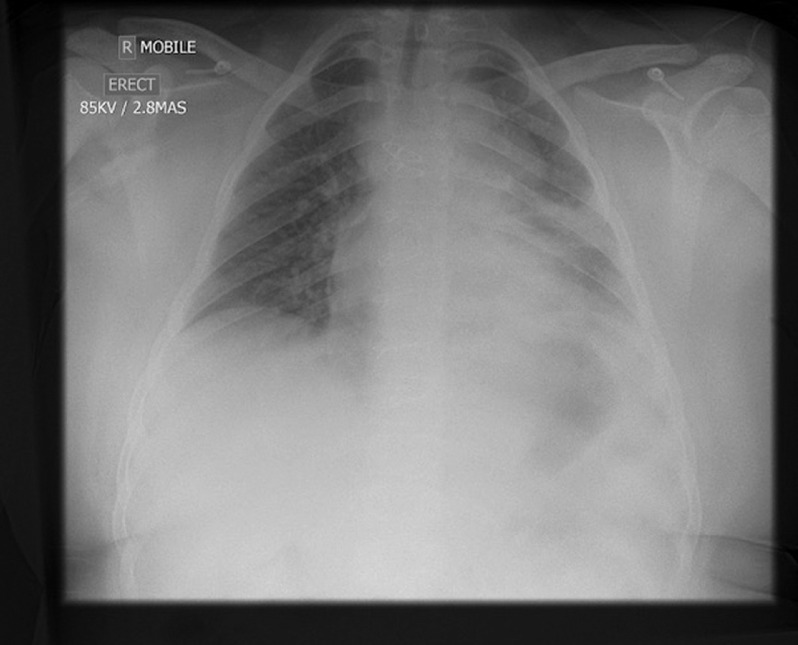
Chest X-ray day 9.